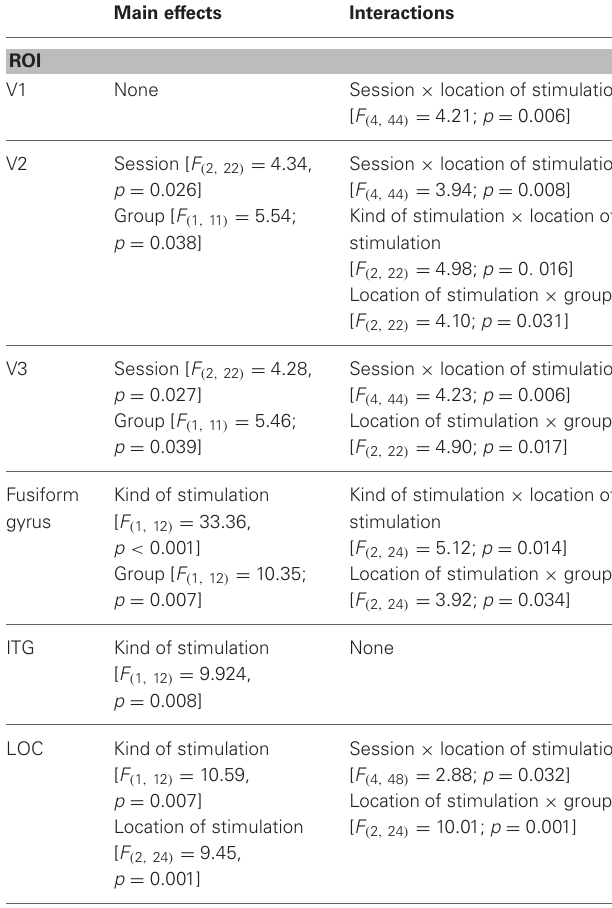
Table 3 | Results of repeated-measures ANOVAs (significant main effects and interactions) with the three within-subject factors “sessions” (before, during, after training), “kind of stimulation” (flickering checkerboards vs. pictures of everyday objects) and “location of stimulation” (PRL vs. OppPRL) and the between subject factor “group” (patient vs. control) with respect to the dependent variable “percent signal